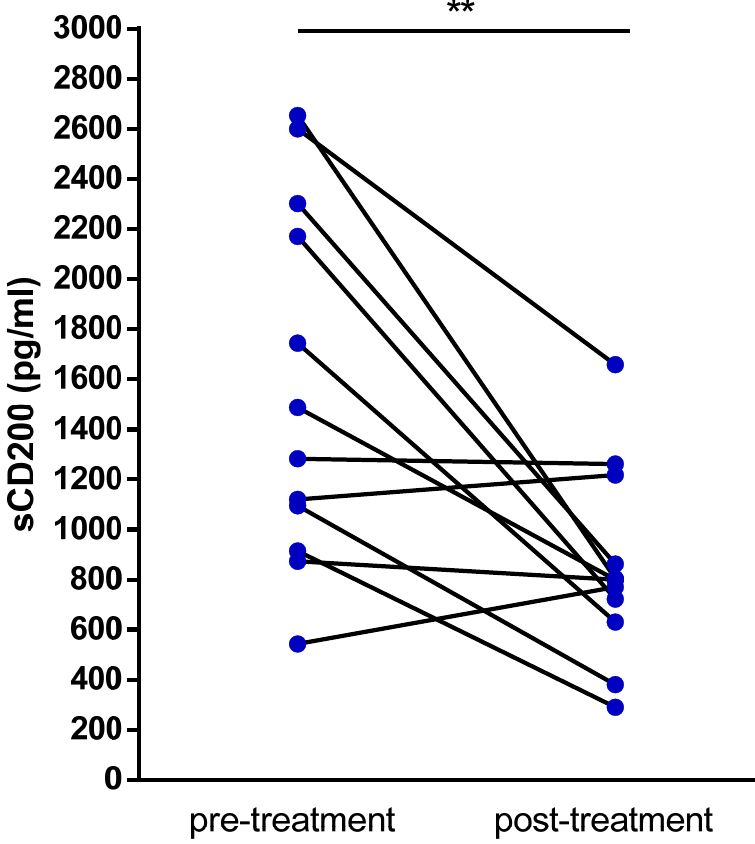
Figure 4. Pre- and post-treatment sCD200. Each dot represents the value for the sCD200 serum concentration from a single patient, assessed before and after chemo-immunotherapy treatment. ** p < 0.01.